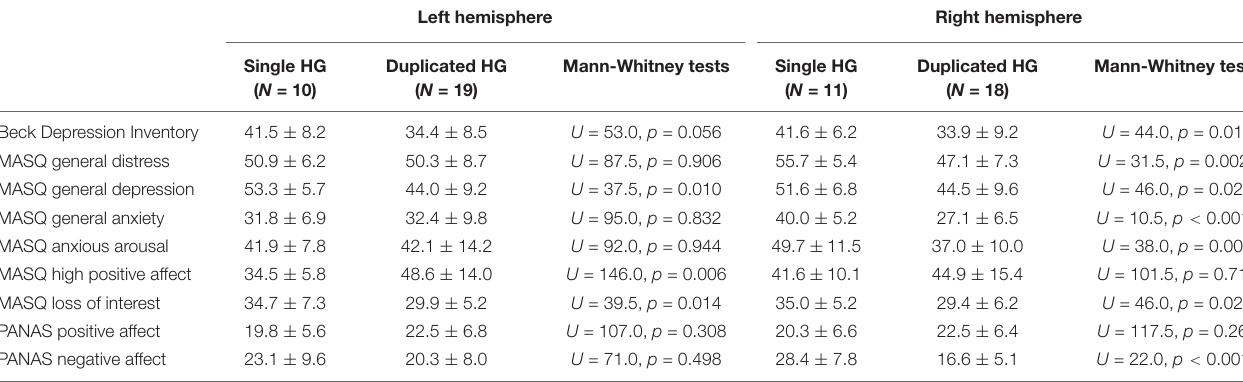
TABLE 4 | Symptom ratings of the currently depressed patients with different Heschl’s gyrus (HG) patterns. Left hemisphere Right hemisphere Single HG Duplicated HG ( N = 10) ( N =